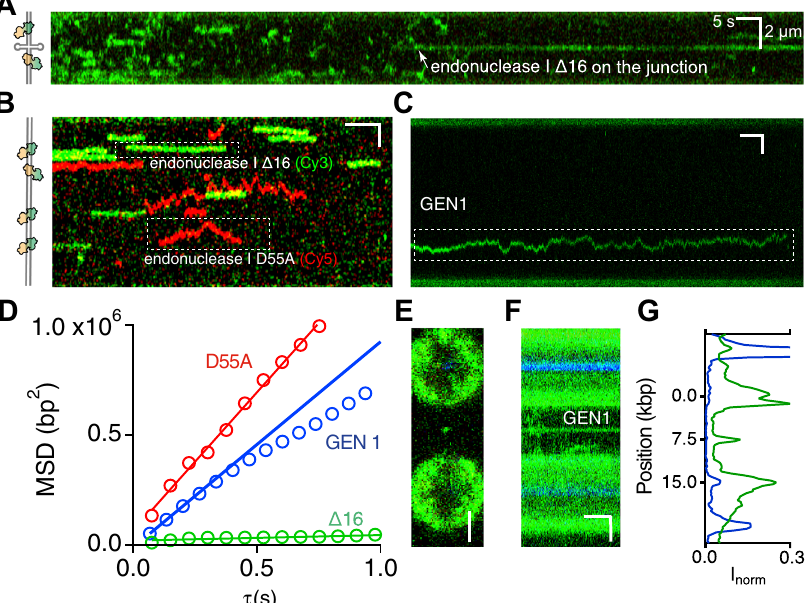
fi t to the MSD dependency yields the diffusion coef fi cient of diffusing endonu- dumbbellwithGEN1(greenspotatthecentre)boundtotheDNA(unlabelled).Scale bar corresponds to 2 μ m. F A kymograph showing GEN1 docked on a centrally- positioned four-way junction. G Cumulative fl uorescence intensity pro fi le of the kymograph in panel F . Central peak corresponds with the junction-bound GEN1. ThepositionontheDNA(inkbp)wasinterpolatedfromthepixelpositionusingthe bead centres (blue peaks) as a